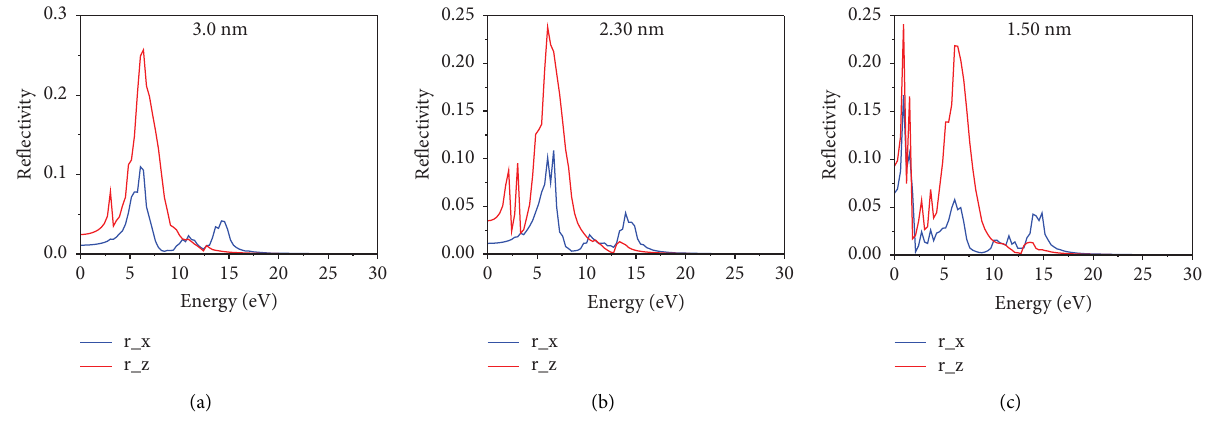
Figure 13: Optical refectivity for armchair CBNNT under diferent